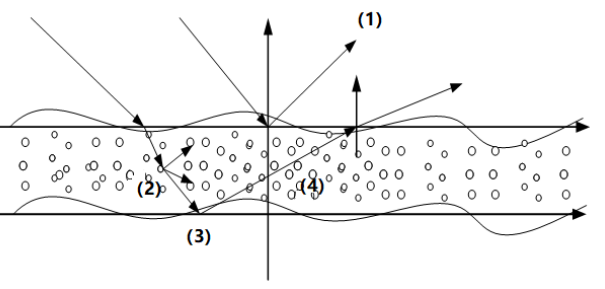
Figure 5. The demonstration diagram of EM scattering from oil spill-covered sea; (1), (2), (3), and (4) represent the four part contributions of an oil spill layer.